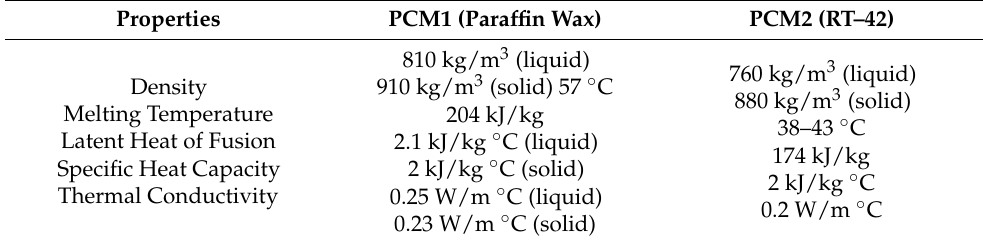
Table 1. Thermophysical properties of PCM1 and PCM2